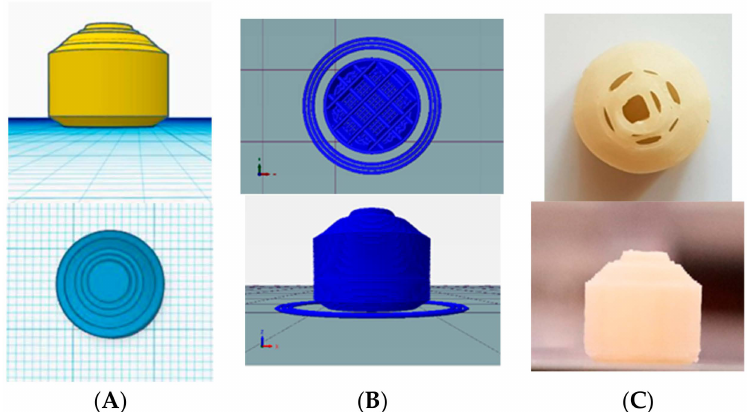
Figure 8. Top view and side view of optimized formulation. Design of unique shaped optimized formulation ( A ), slicing of tablets with 25% infill ( B ) and printed tablets ( C ).